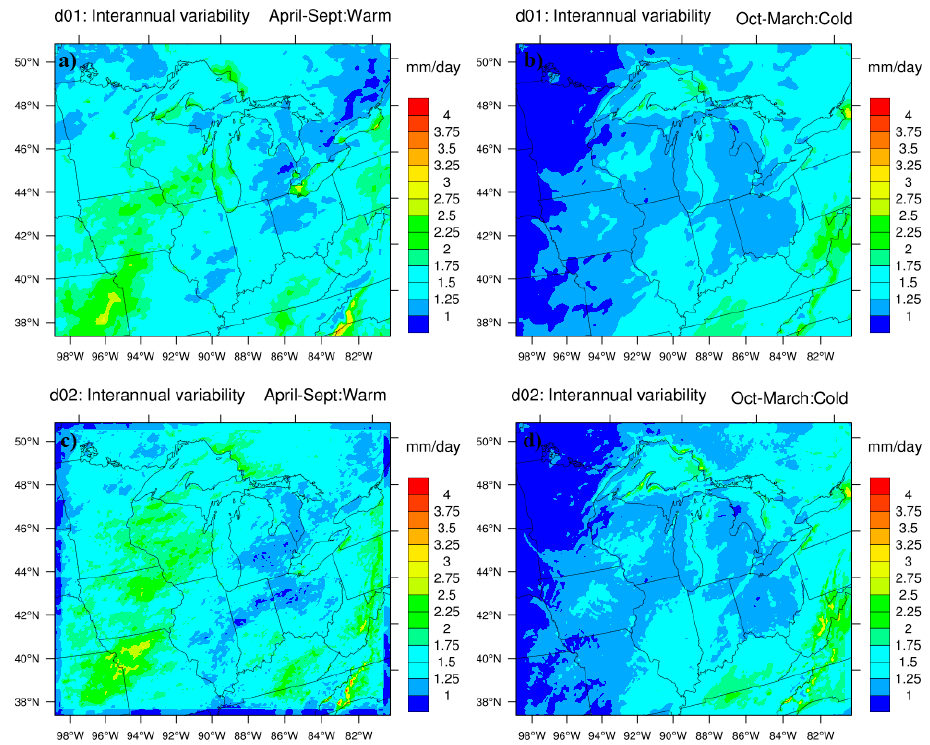
Figure 5. Same as Figure 4 but for interannual variability of simulated WRF model precipitation.